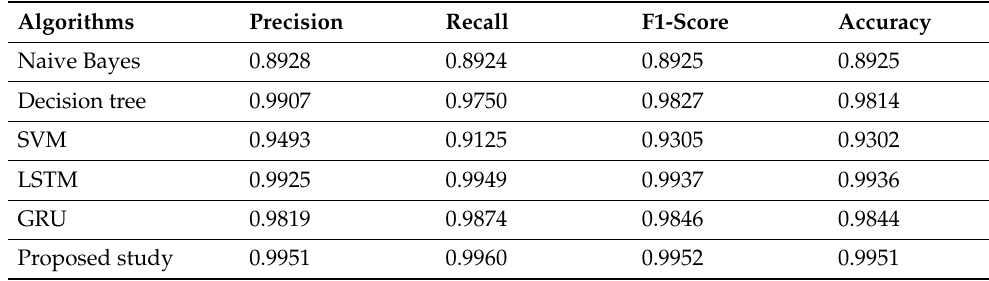
Table 4. Comparison of the HDL-IDS with other ML algorithms on the combined DDoS dataset.